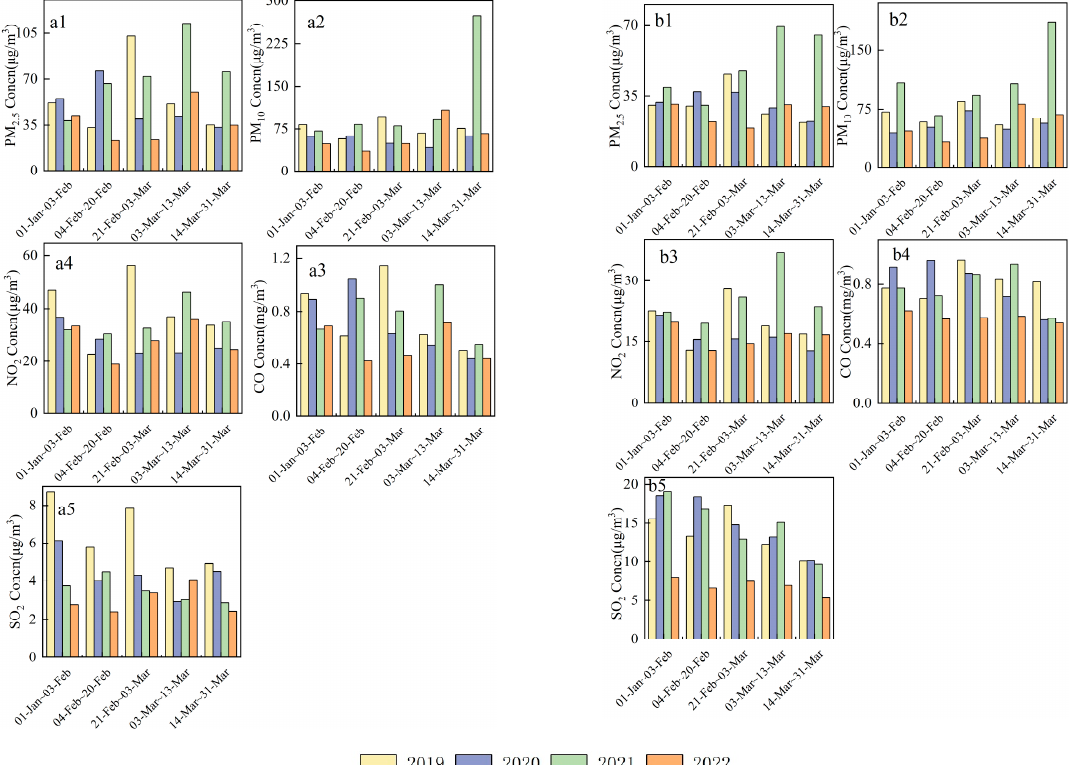
Figure 2. Average pollutant concentrations in ( a ) Beijing and ( b ) Zhangjiakou during different peri- ods. ( a1 – a5 ) show the PM 2.5 , PM 10 , NO 2, CO, and SO 2 concentration in Beijing respectively, ( b1 – b5